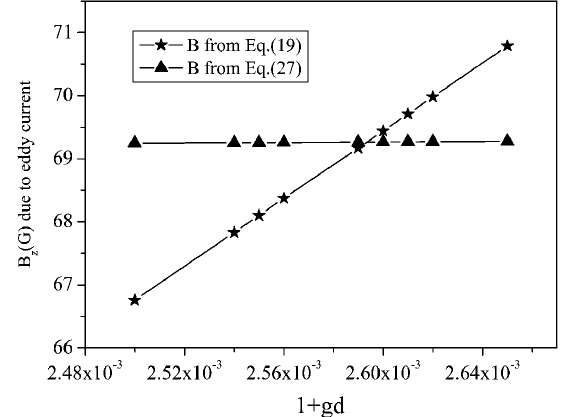
FIG. 5. Plot of the magnetic field on the surface of the plate obtained using two different methods using Eqs. (19) and (27), respectively. The value of ( 1 þ gd ) is obtained from the inter- section of two